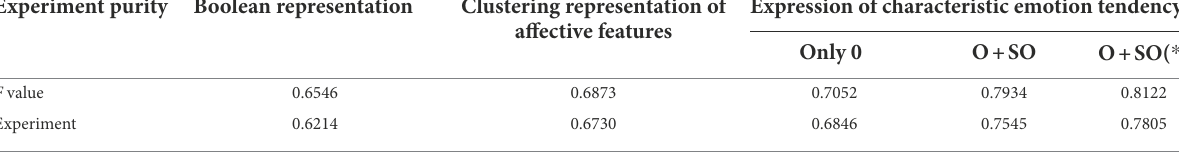
TABLE 5 Purity and F value of clusters under different characteristic representations.